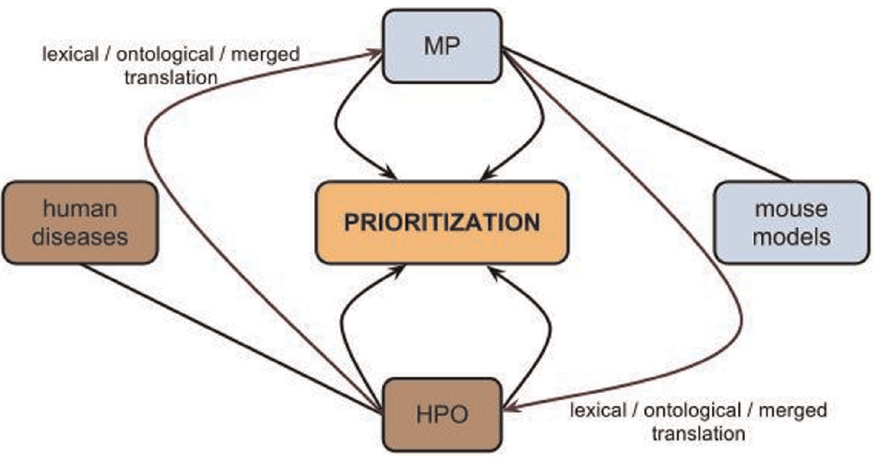
Figure 3. Highlights the applied transformation in our method. Our mappings are not symmetrical. Therefore, we can ‘‘translate’’ phenotype concepts in two directions: we can translate all mouse models into an HPO-based representation (using either the lexical, ontology-based or merged mapping approach), and we can translate all human diseases into an MP-based representation (using either of the mappings). When both mouse phenotypes and human diseases are represented using the same ontology, their similarity can be computed to suggest candidate disease genes. The original data obtained from OMIM (disease annotations in HPO) is illustrated with a brown color whilst the data obtained from MGI is illustrated with a light blue color. The purple arrows show the ‘‘translation’’ process using either the lexical, the ontological or the combined mapping. Once diseases and mouse models are represented using the same ontology, the prioritization based on a phenotype similarity will be calculated.